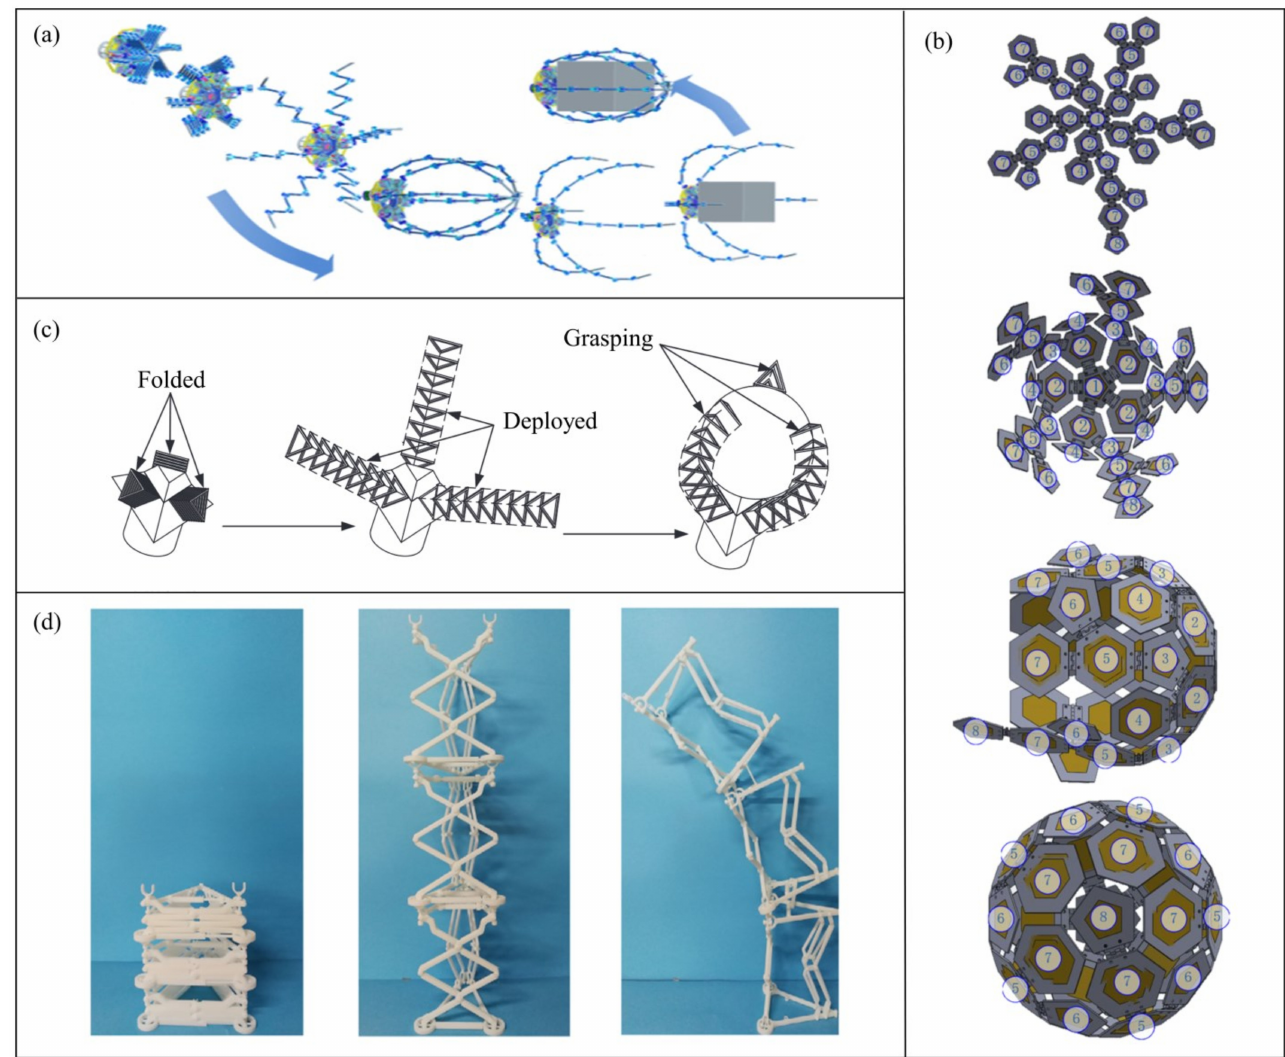
Figure 7. Externally folded end-effector: ( a ) the typical capture flow of closed configuration [159]; ( b ) externally folded capture device based on the origami principle [160]; ( c ) deployable grasping mechanism [161]; ( d ) basic deployable modules